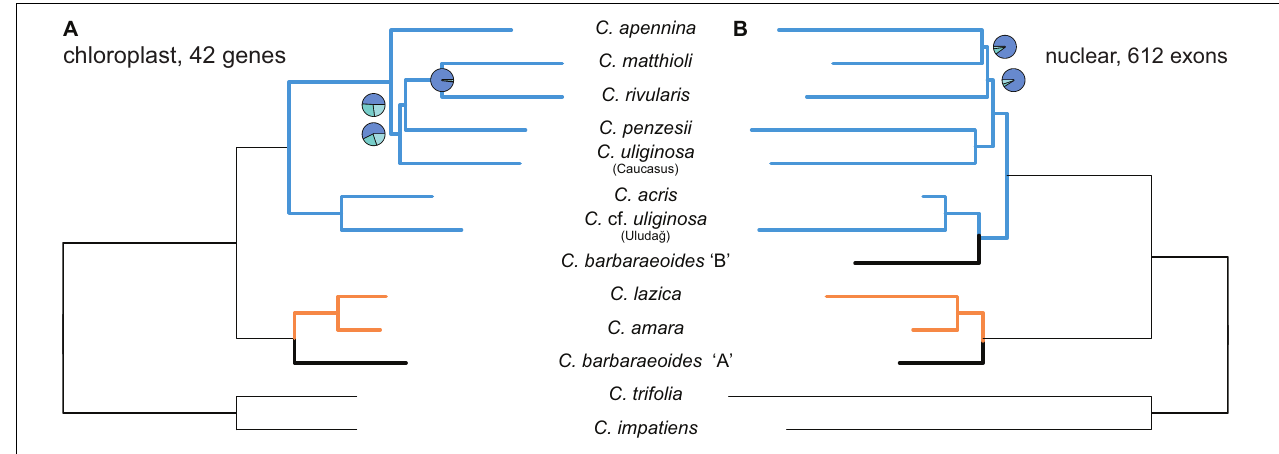
FIGURE 7 | Species trees inferred in ASTRAL-III from the dataset of 42 protein-coding most informative chloroplast genes (A) and 612 nuclear exons [ (B) , as in Figure 5A ]. Branch support is shown by pie charts, depicting three local posterior probabilities for the given branch (not shown for the fully supported branches). Tree branches are colored according to the group membership; branches in black show Cardamine barbaraeoides .